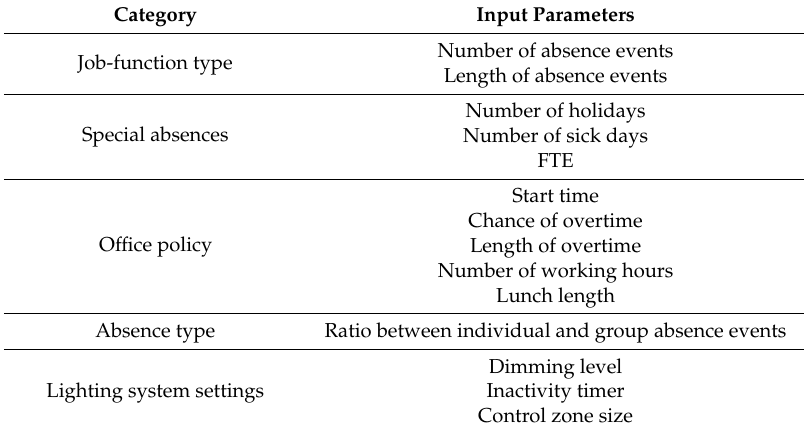
Table 1. Input parameters used to define the office case when setting up the model.